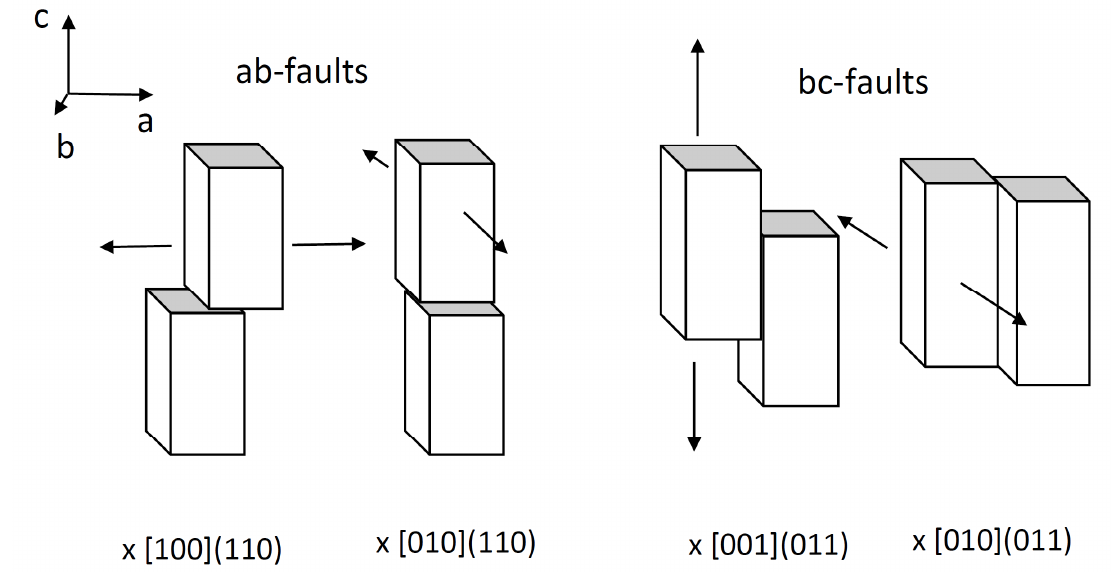
Figure 5. Schematic sketch showing two displacement possibilities of consecutive unit cells in VPP for each ab- and bc- faults.